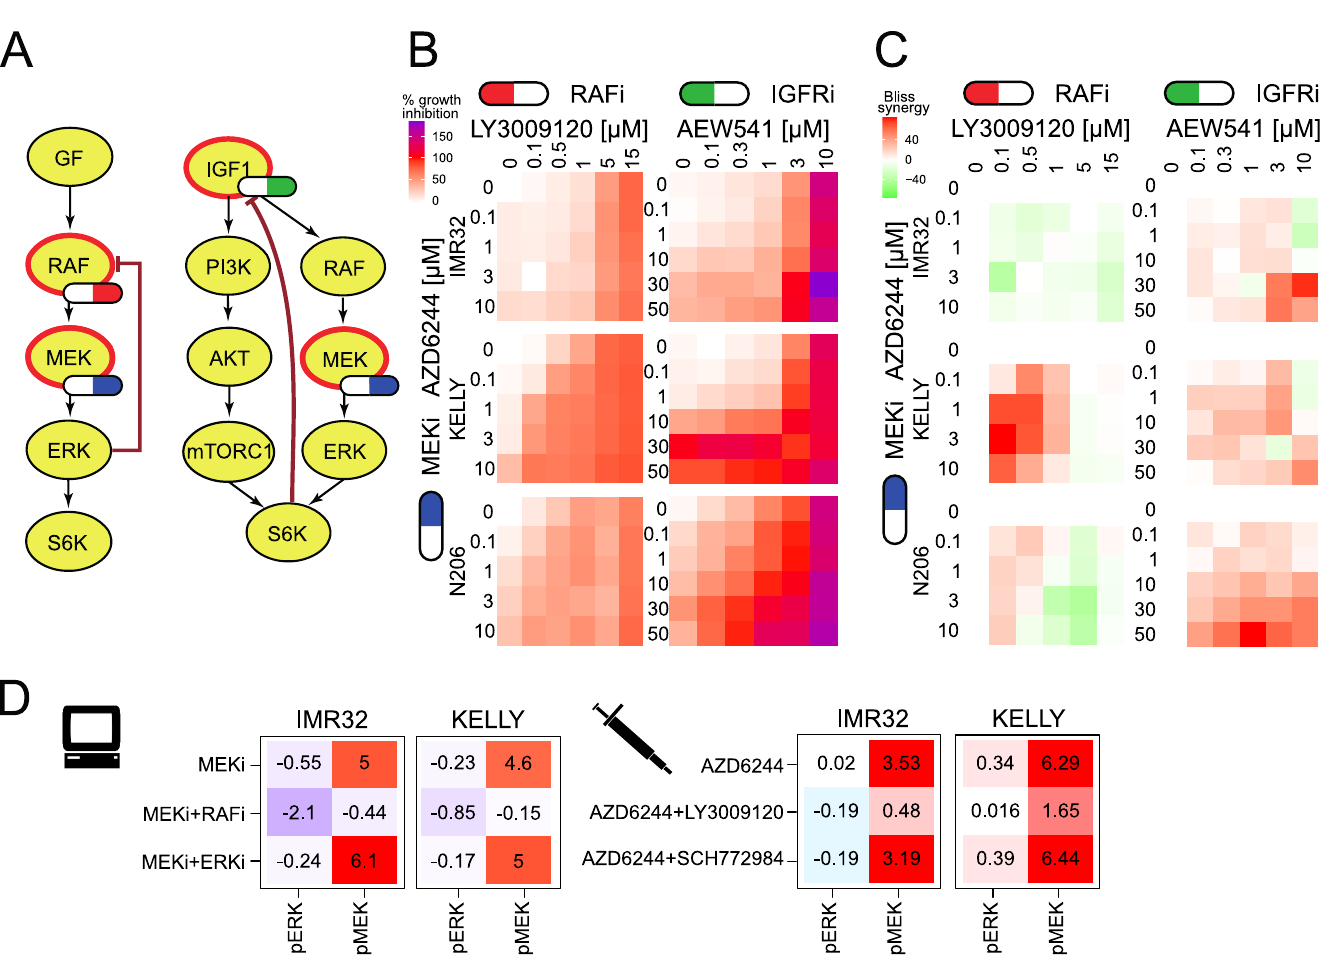
Fig 6. AZD6244 resistant cell lines can be sensitised with combined inhibition with the IGFR inhibitor AEW541 or the RAF inhibitor LY3009120. A: Model- inferred targeting strategy of dual inhibition. B: Growth inhibition measurements for various combinations of the MEK inhibitor AZD6244 with the RAF inhibitor LY3009120 or the IGFR inhibitor AEW541. Values over 100 indicate cell death. n = 2. C: Bliss synergy corresponding to the measurements in B. D: LEFT : Model predictions of pERK and pMEK activity for MEK inhibition alone and in combination with inhibition of upstream kinase RAF or downstream kinase ERK for KELLY and IMR32. Values are log-fold changes to IGF1 condition with inhibitor strength set to -1. D: RIGHT : pERK and pMEK plex measurements in KELLY and IMR32 after 90min treatment of the MEK inhibitor AZD6244 in combination with either DMSO, SCH772984 (ERKi, 10 μ M) or LY3009120 (RAFi, 5 μ M) in cells grown with 10% FCS. Values are log-fold change to FCS medium